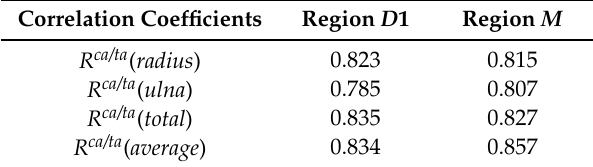
Table 2. Correlation coefficient r values according to the type and the regions of M and D 1.